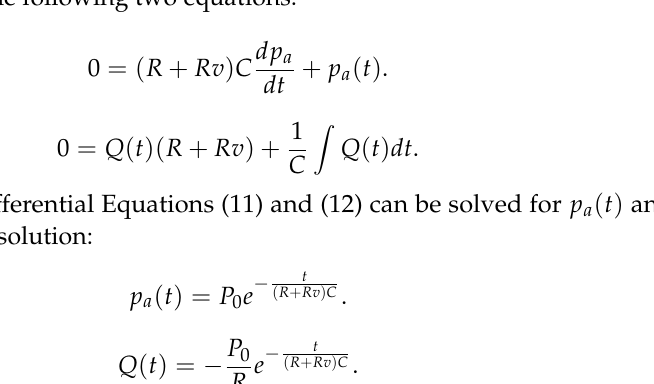
Figure 13. Lung model: p ( t ) is pressure source of ventilator (mbar), Q ( t ) is air flow (mL/s), R is lung resistance (mbar/L/s), Rv is ventilator related resistance, C is lung compliance (mL/mbar), and Cv is ventilator-related compliance